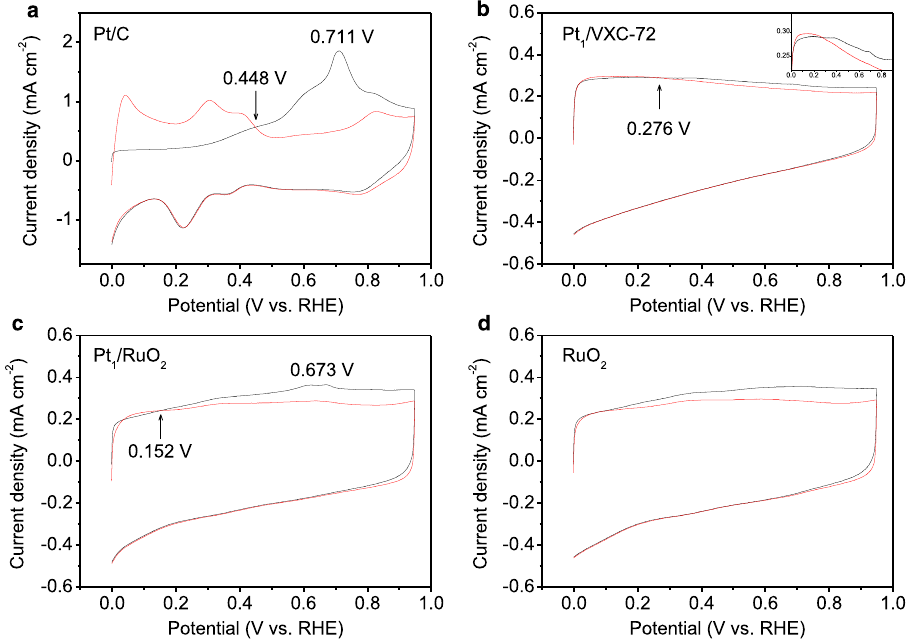
Fig. 5 CO stripping tests in 0.1 mol L ‒ 1 KOH at a scan rate of 50 mV s ‒ 1 . a 20 wt% commercial Pt/C. b Pt 1 /VXC-72. Inset in ( b ) is the local enlargement. c Pt 1 /RuO 2 . d RuO 2 . The black and red curves correspond to the fi rst and second scans, respectively. The fi rst scan was recorded in the presence of CO adsorbed on the electrode, while the second scan was recorded in absence of